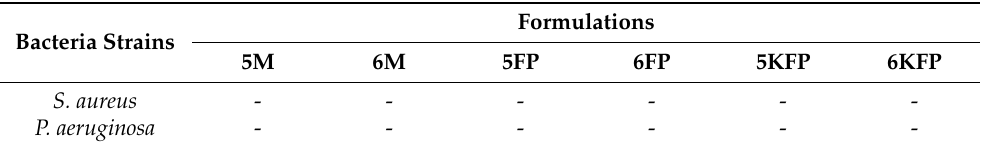
Table 3. Results of film-forming gels microbiological